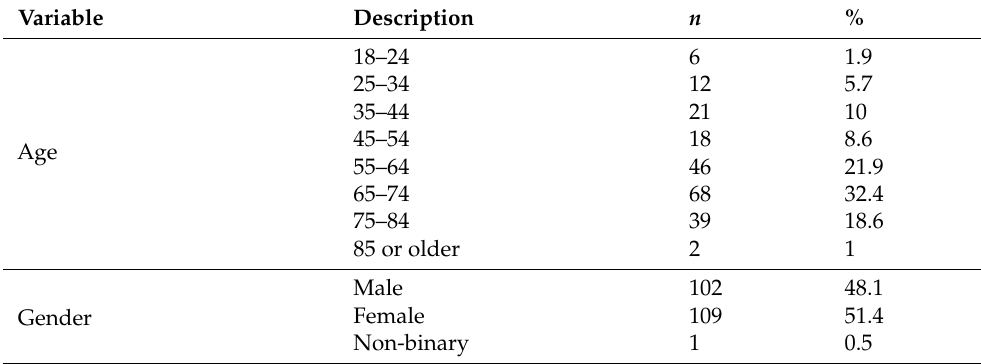
Table 1. Demographic characteristics of the survey